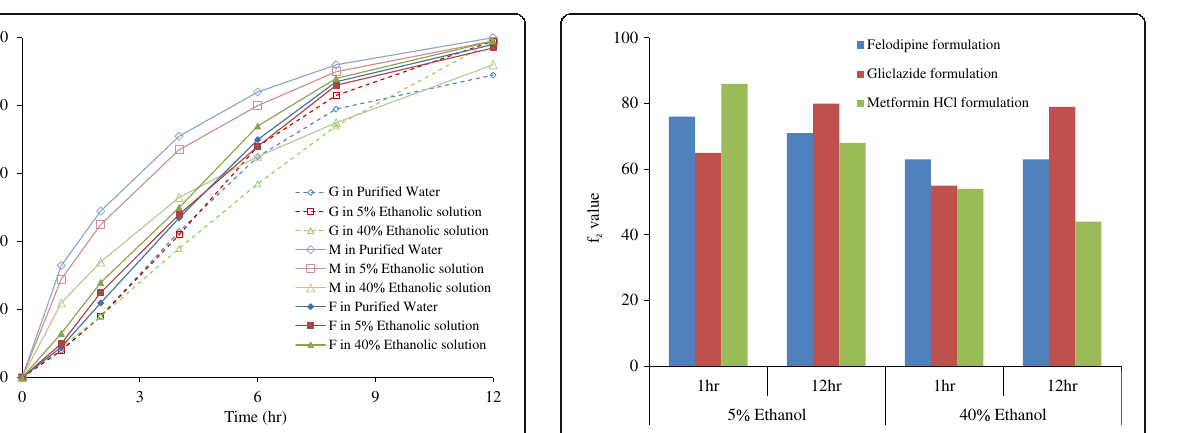
Fig. 20 Comparison of f 2 values for drug release profiles from HPMC matrices in ethanolic media to when they were not exposed to ethanol solutions (data from reference (Levina et al. 2007))